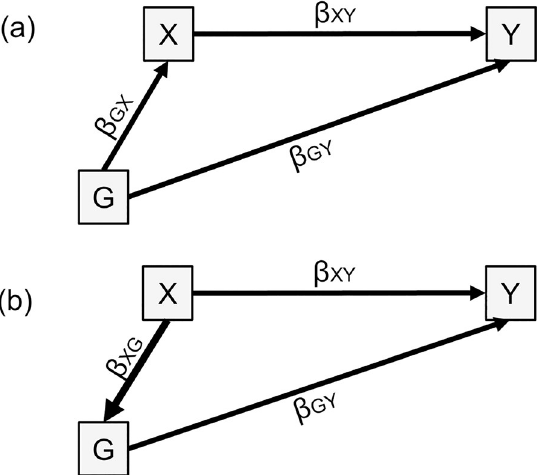
Fig 3. Genetic confounding, one polygenic score case. Fig 3A represents the underlying model. Fig 3B represents the model to calculate the confounding effect by treating G as a ’mediator’. Of note is that the commonly used terminology ‘genetically mediated’ can be confusing. Although ‘genetically mediated’ makes sense statistically, conceptually, a mediator is on the causal pathway from the predictor to the outcome. However, because germline genetic variants are set at conception and do not change throughout the lifespan, posterior exposures (e.g. individual alcohol intake) cannot influence health outcomes (e.g. depression) through modifying germline genetic variants [34]. Although statistically treated as a mediator here to estimate confounding, conceptually G does not qualify as a mediator. Variances not represented for simplicity.